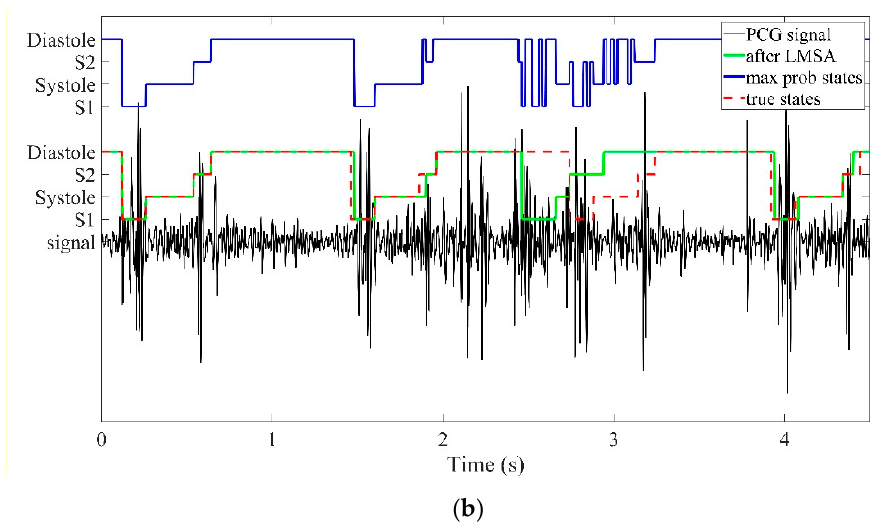
Figure 8. Examples of state annotation methods for correcting fixed state order errors in the classification result. Max prob states was obtained as the highest probability state for the classification result at each time point. ( a ) Viterbi algorithm. After Viterbi the state sequence was corrected using the Viterbi algorithm. ( b ) LSMA. After Limited Max Sequential Annotation (LMSA) the state sequence was corrected by limited max sequential annotation.